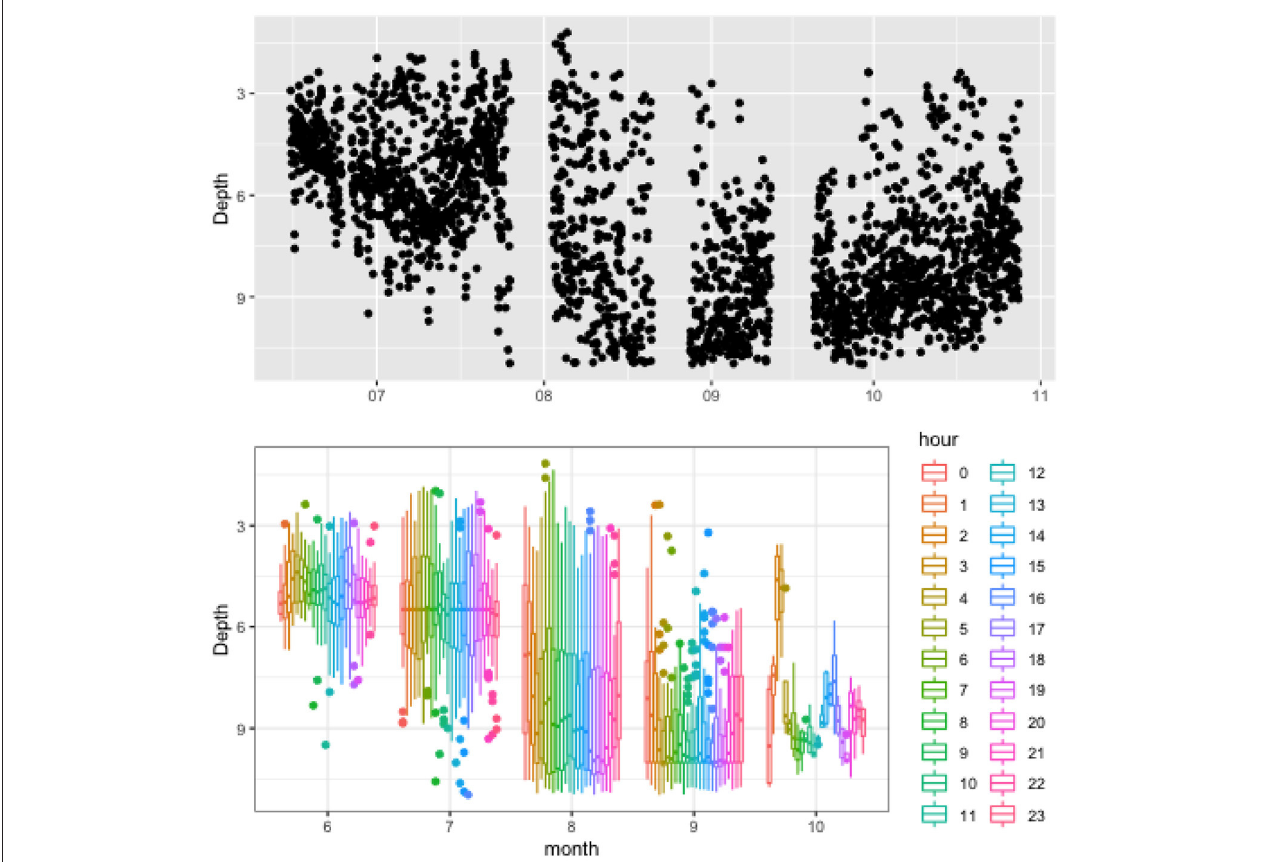
FIGURE 3 | Vertical distribution of fish in a cage at NOR farm illustrating the evolution of the centrepoint of fish biomass over the duration of study period (top) and boxplot of the data grouped into hourly intervals for each month (bottom). The box plot provides insight into distinct patterns developing in the data at different times with the color legend representing hour of day. Lines extending from the boxplot represent the range of data (i.e., minimum and maximum values), while the box section reports 25th percentile, median, and 75th percentile values. Filled circles represent outliers for the